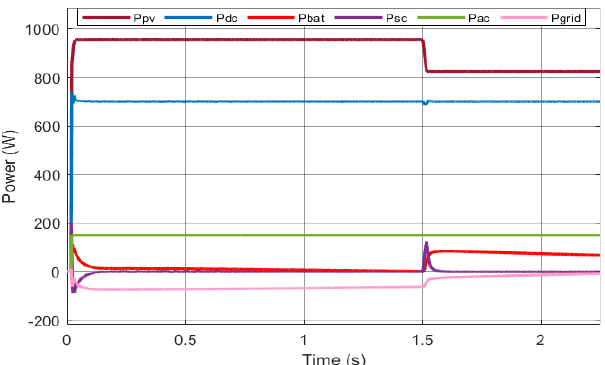
13 of 21 Figure 12. Islanded mode PCC and DC bus voltage value. 4.2. Grid-Connected Mode In this mode, as the grid is available, the PMS supplies/draws balance power to/from the grid. There are two sub-modes for the grid-connected mode, i.e., deficit power and surplus power modes. These simulated scenarios are discussed in the following section.